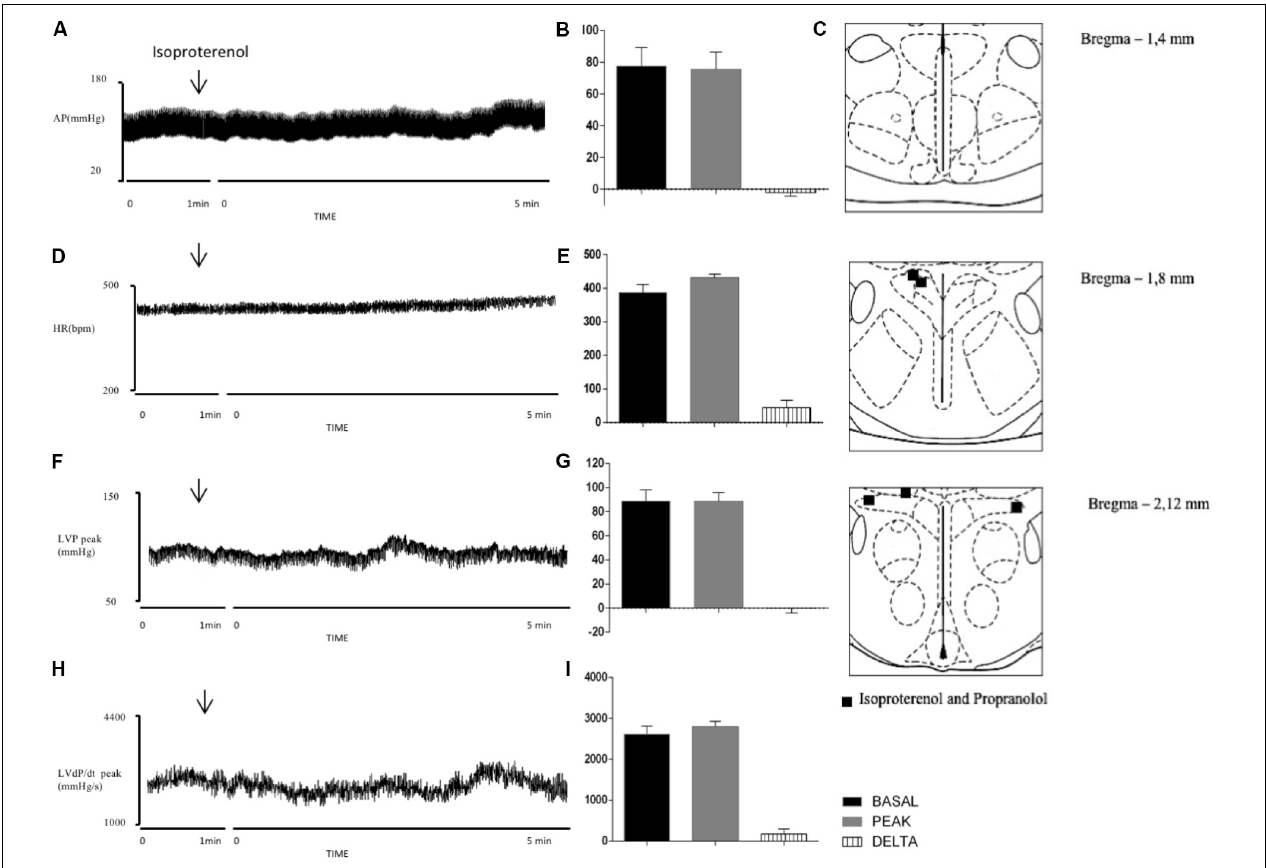
FIGURE 6 | Left column – Charts records illustrating the responses of MAP (A) , HR (D) , LVP peak (F) , and LVdP/dt peak (H) produced by the unilateral microinjection of isoproterenol in PVN (arrows indicate the moment of injection). Middle column – Mean maximal changes in MAP (B) , HR (E) , LVP peak (G) , and LVdP/dt peak (I) in response to unilateral microinjections of isoproterenol (100 nl). Values refer to the means collected in the basal period (2 min before the central injection), and at the maximum point of response to microinjection and its variation. ∗ P < 0.05. MAP, mean arterial pressure; HR, heart rate; LVP peak, maximum pressure in the left ventricle; LVdP/dt peak, first derivative of cardiac left ventricle pressure. Right column – Schematic representation of the injection sites stained by Evans blue dye from group injected with isoproterenol and propranolol (100 nl) into PVN (C) . n =